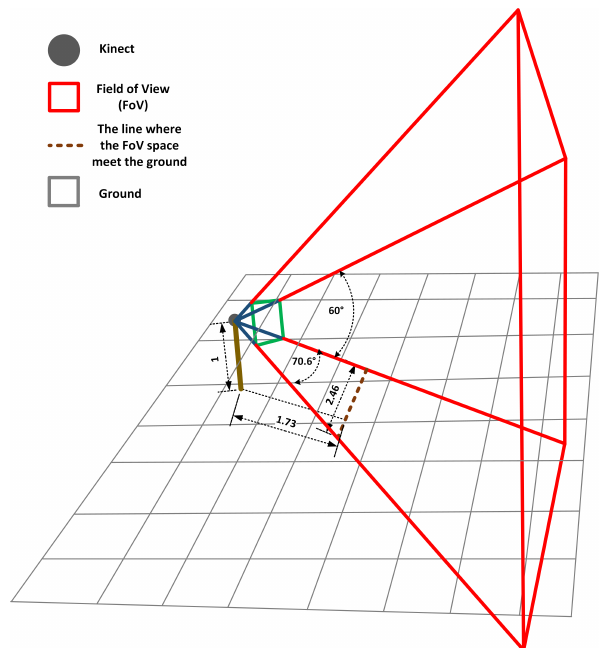
Figure 5. Demonstration of the effective capture space of a Kinect depth sensor. In this scenario, the Kinect sensor (represented by a black circle) is placed at a tripod 1 m above the groud (represented by grey grids) with 0 ◦ title. The demo uses the depth sensor of Kinect v2 as the example. The horizontal and vertical FoV of the depth sensor are 70.6 ◦ and 60 ◦ , respectively. The intersection line of the FoV space and the ground is around 1.73 m far from the sensor and the width of the intersection line is around 2.46